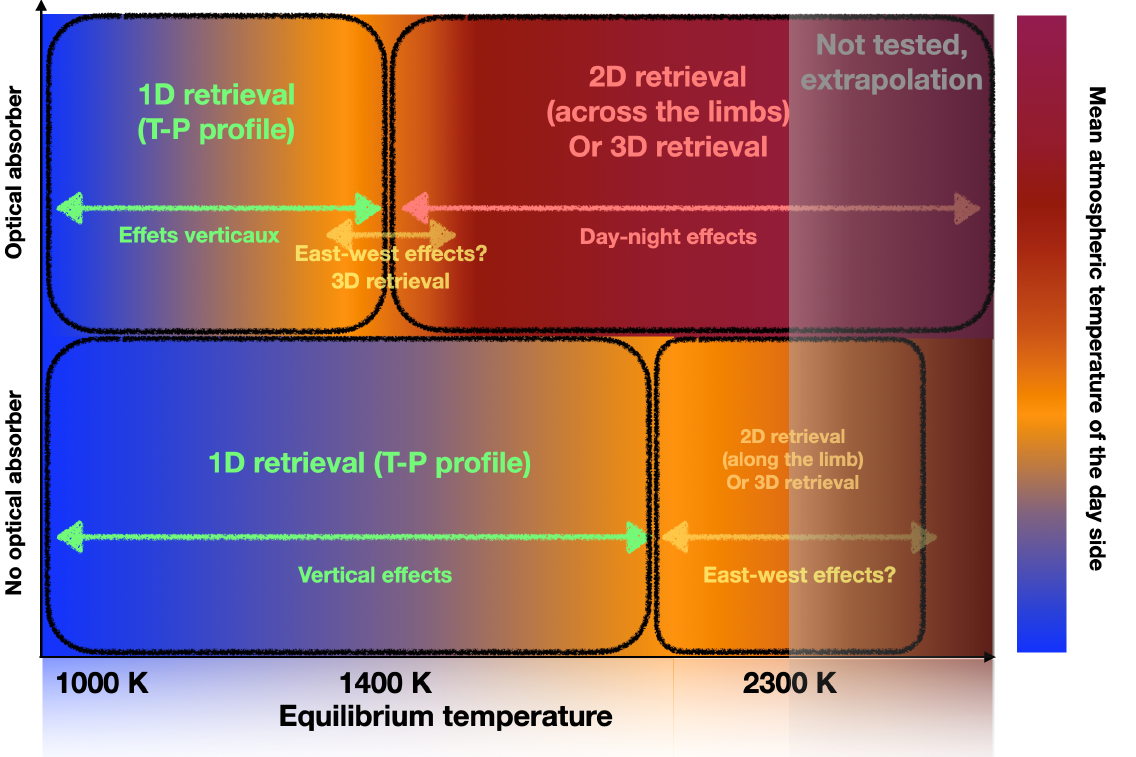
Figure 12. Summary of the different geometries required in retrieval codes to avoid biases as a function of the equilibrium temperature of the planet and the presence or absence of optical absorbers (hence, thermal inversion). One-dimensional retrieval models appear to provide relatively satisfactory parameter estimates for planets with equilibrium temperatures lower than 1400 K when optical absorbers (TiO, VO, K, Na, metals, ionized hydrogen, etc.) are present in the atmosphere. However, they lead to biased parameter estimates above this limit, where 2D or 3D retrieval codes are mandatory. When no optical absorbers are present in the atmosphere, the validity of the 1D retrieval code extends to an equilibrium temperature of 2000 K. Above this temperature, the estimated parameters become biased, probably due to east–west effects, which require 2D or 3D models to unravel the complexity of the spectrum. However, we suggest clues for the effect of the east–west asymmetry, and further investigations are needed to quantify their effects. Figure adapted from Pluriel et al.